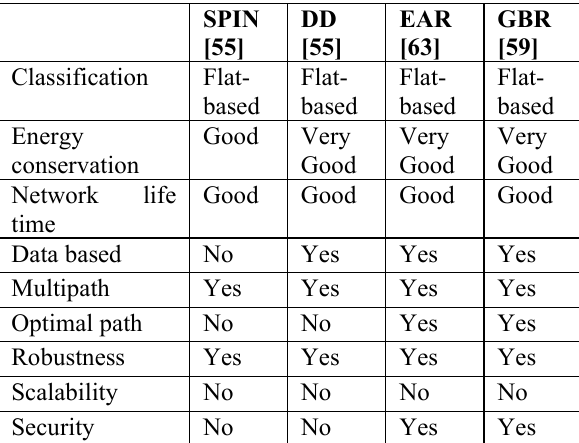
Table 2. Performance Comparison of Flat-Based Routing